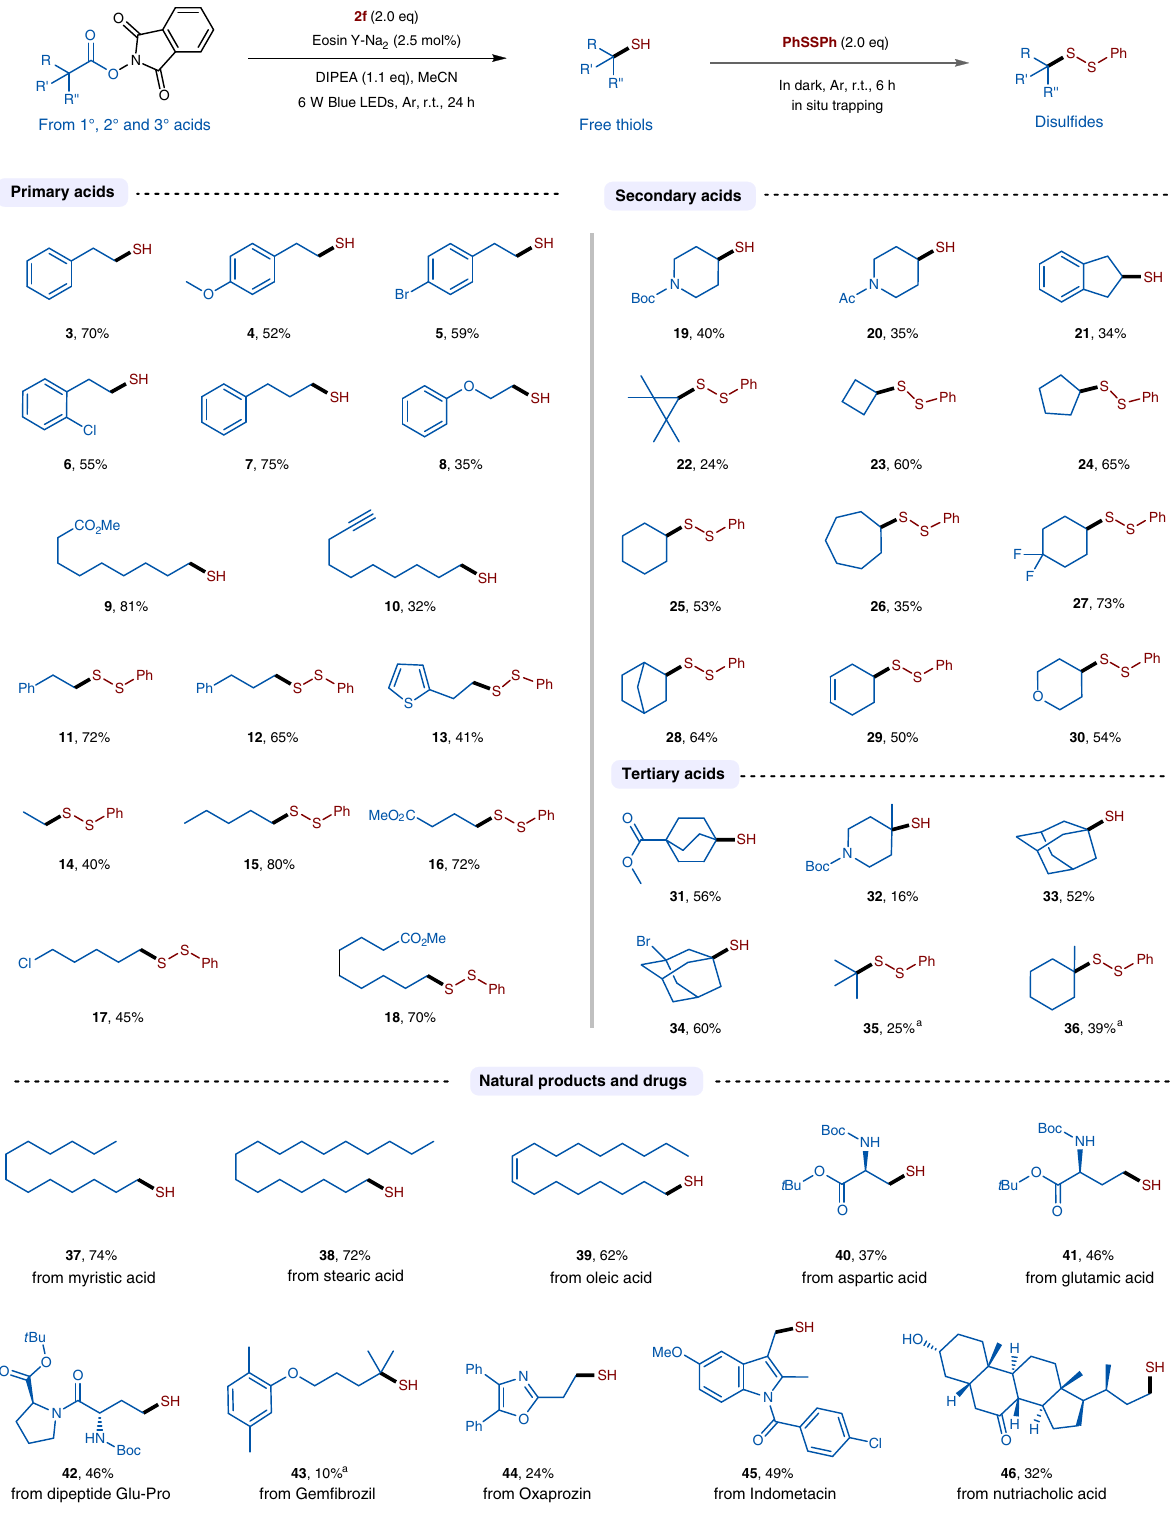
Fig. 2 Substrate scope. Reactions were performed on a 0.2 mmol scale, and trapping reactions were conducted with 2.0 equiv. of PhSSPh in dark for 6 h. a In CF 3 CH 2